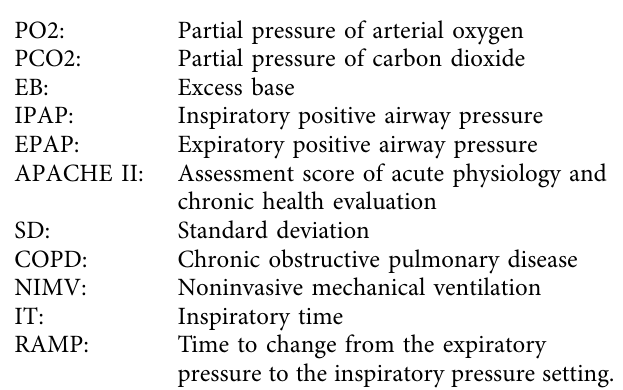
2 /FiO 2 : ratio of partial arterial oxygen pressure and inspired fraction of